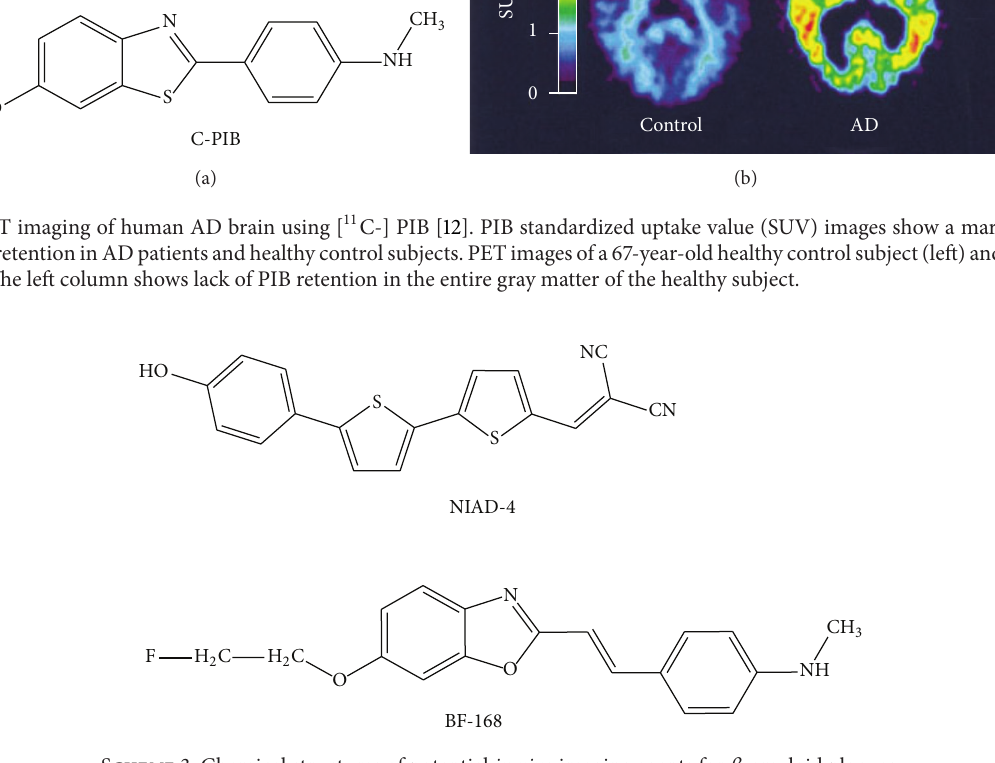
Scheme 3: Chemical structures of potential in vivo imaging agents for 𝛽 -amyloid